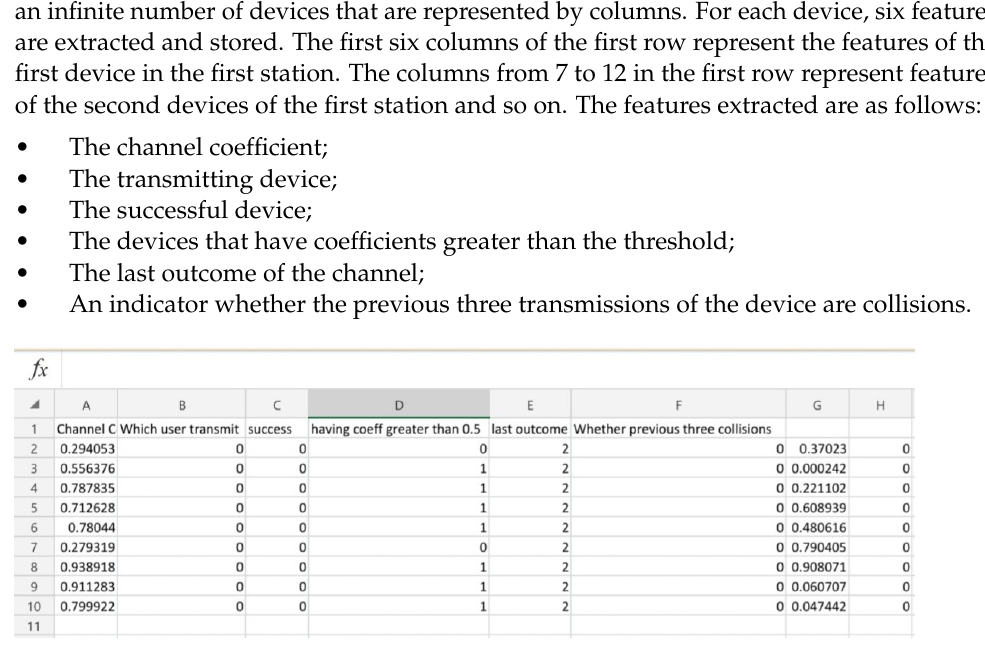
Figure 7. Extracted features to train the